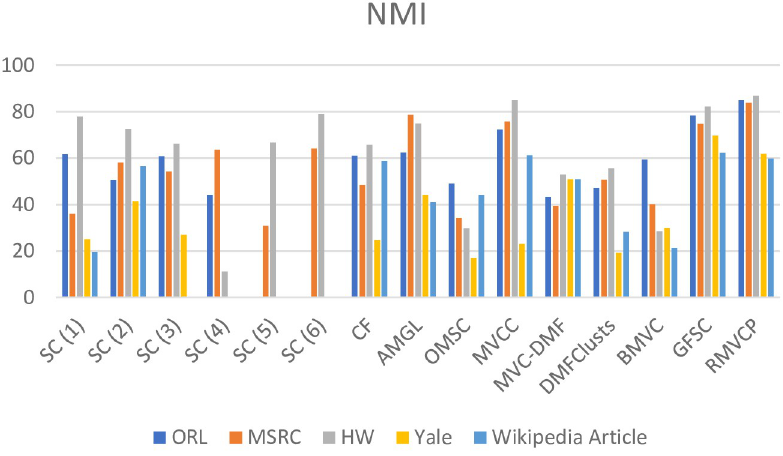
Fig 5. A histogram comparison of the NMI results of all algorithms on the five